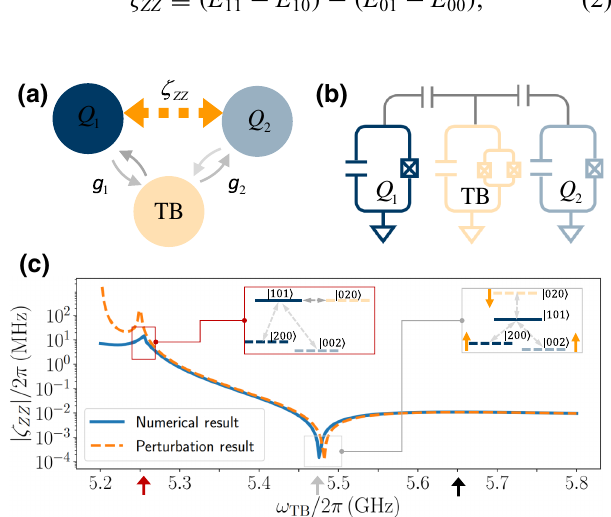
FIG. 1. (a) Sketch of a coupled two-qubit system ( Q 1,2 ) with tunable ZZ interaction ζ ZZ enabled by the tunable bus (TB). (b) Circuit diagram of two fixed-frequency transmons coupled via a frequency-tunable transmon (treated as a tun- able bus). (c) ZZ coupling ζ ZZ as a function of bus fre- quency ω TB for the qubit system illustrated in (b) with qubit frequency ω 1 ( 2 ) / 2 π = 5.000 ( 5.200 ) GHz, anharmonicity η 1 = = η = η (η/ 2 π = − 300 MHz ) , and qubit-bus coupling η 2 TB g 1 ( 2 ) = g ( g / 2 π = 25 MHz ) (at ω 1 ( 2 ) = ω TB = 5.500 GHz ) . The blue-solid and orange-dashed lines represent the numerical and perturbational results, respectively. The red arrow indicates the working point where a strong ZZ coupling exists due to the reso- nance interaction | 101 (cid:2) ↔ | 020 (cid:2) (as shown in the inset outlined with the red line), and gray arrow shows the ZZ -free point result- ing from the destructive interference of ZZ contributions from interactions | 101 (cid:2) ↔ {| 200 (cid:2) , | 002 (cid:2) , | 020 (cid:2)} (as shown in the inset outlined with the gray line). To ensure high-fidelity single-qubit addressing, besides the residual ZZ crosstalk, the cross-driving crosstalk due to qubit state dressing should also be taken into consideration (see Sec. II B for details). In light of this, the sys- tem idle point is typically 500 MHz above the qubit in frequency, marked by the black